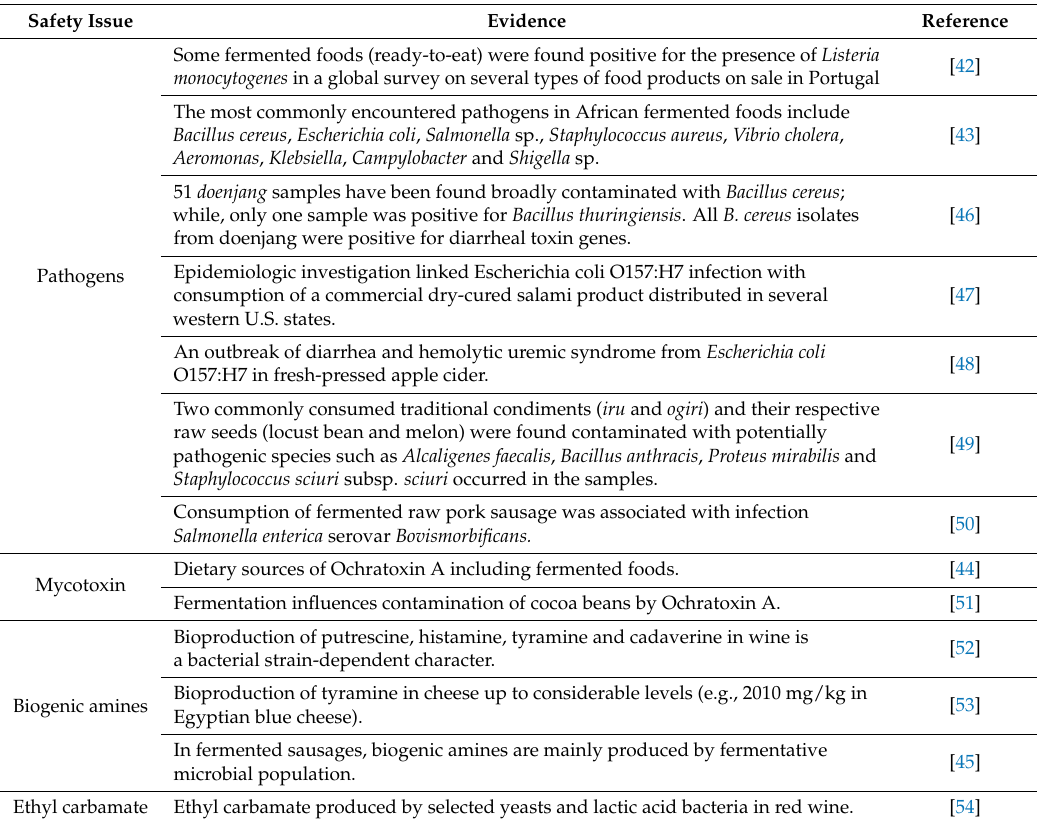
Table 3. Examples of the presence of contaminants of microbial origin hazardous for human health in fermented